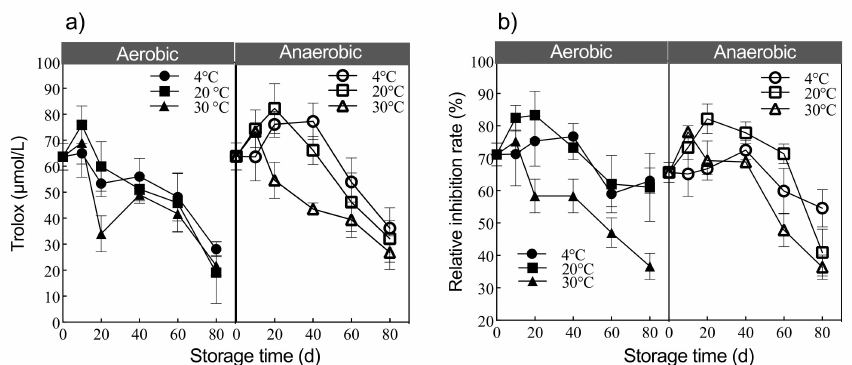
Figure 6. Antioxidant resistance and antifungal activity rate of digestate storage under varying conditions. ( a ) Antioxidant properties of digestate under different storage modes. ( b ) Antifungal properties of digestate under different storage